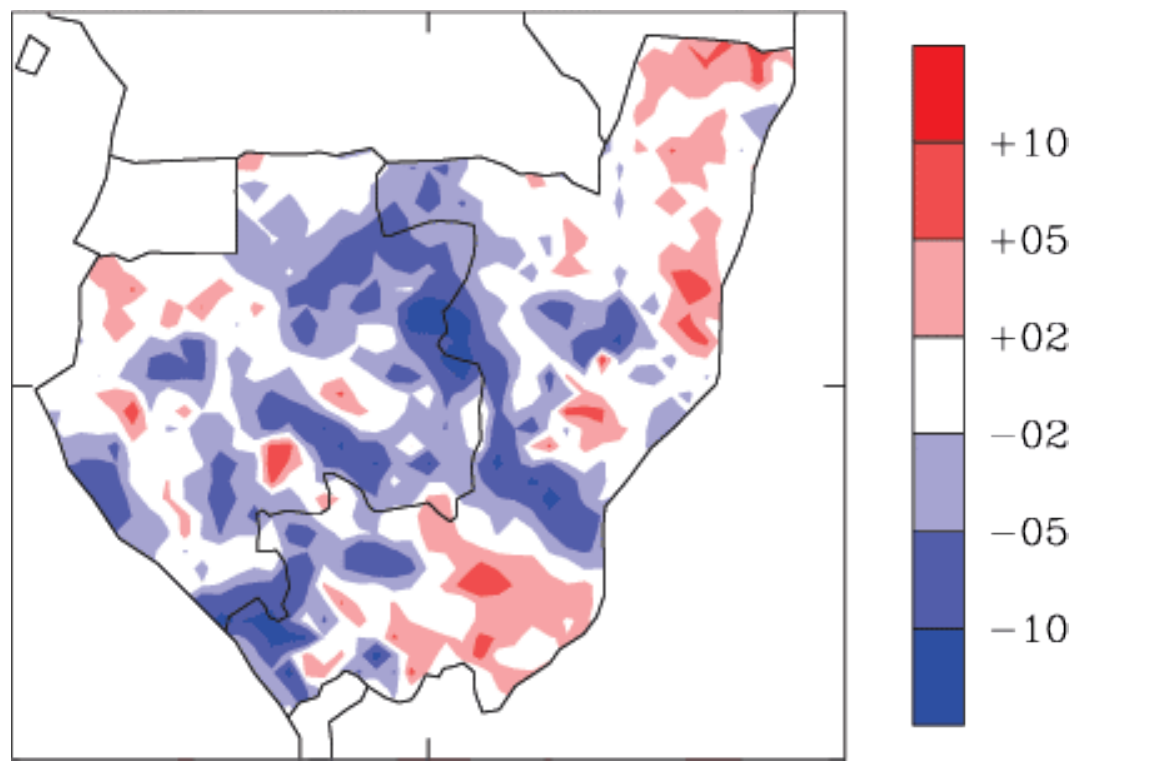
Fig. 3 . Simulated precipitation difference (mm) between control and deforestation scenarios for October 2001 in Gabon and the Republic of